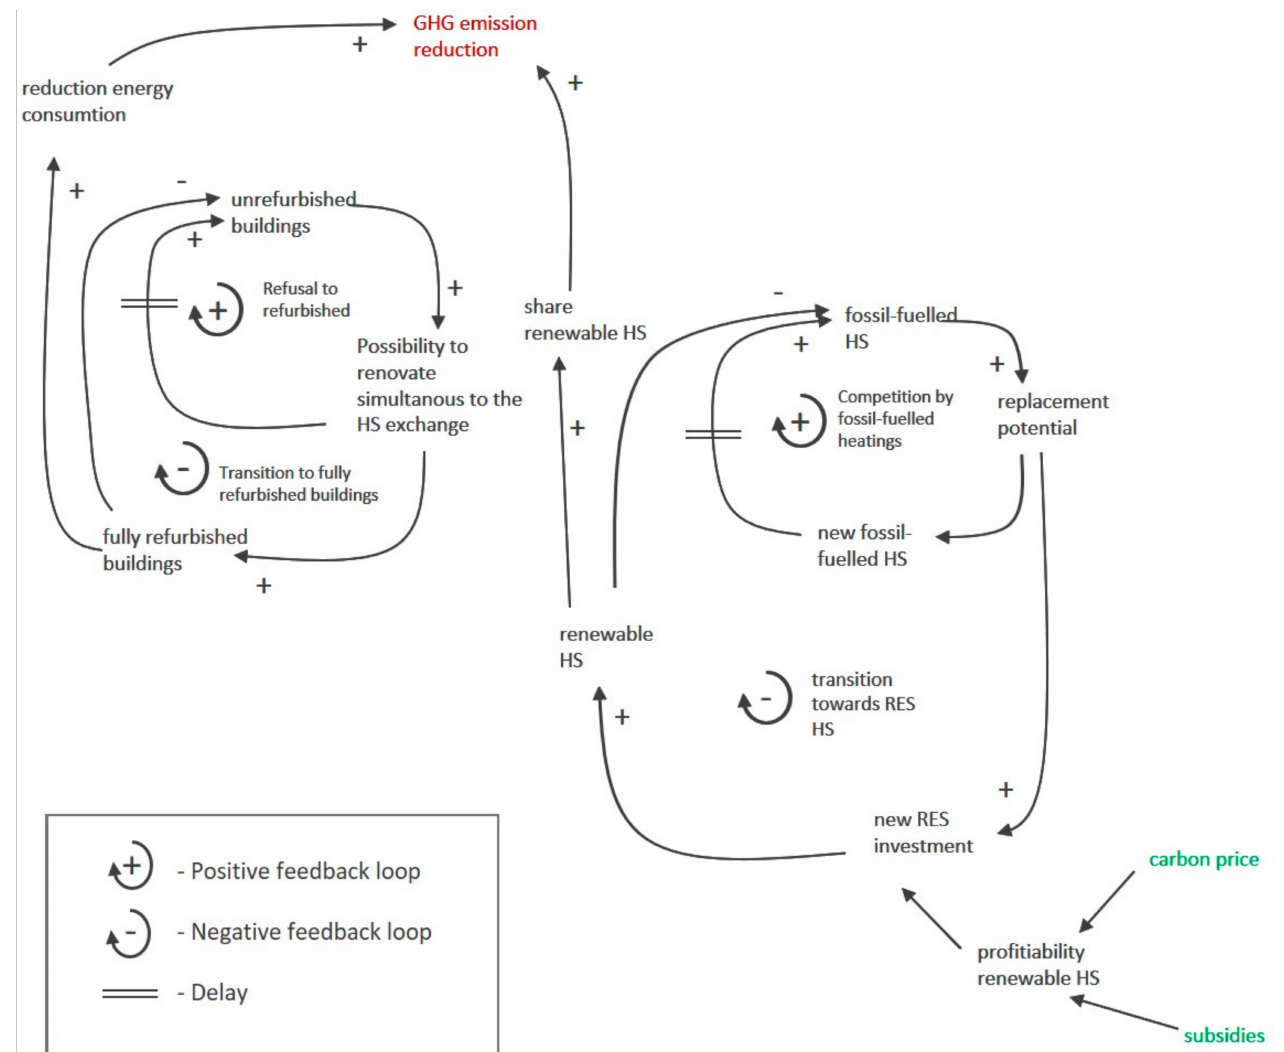
Figure 1. Causal-Loop Diagram of the model, derived from Schmidt et al.